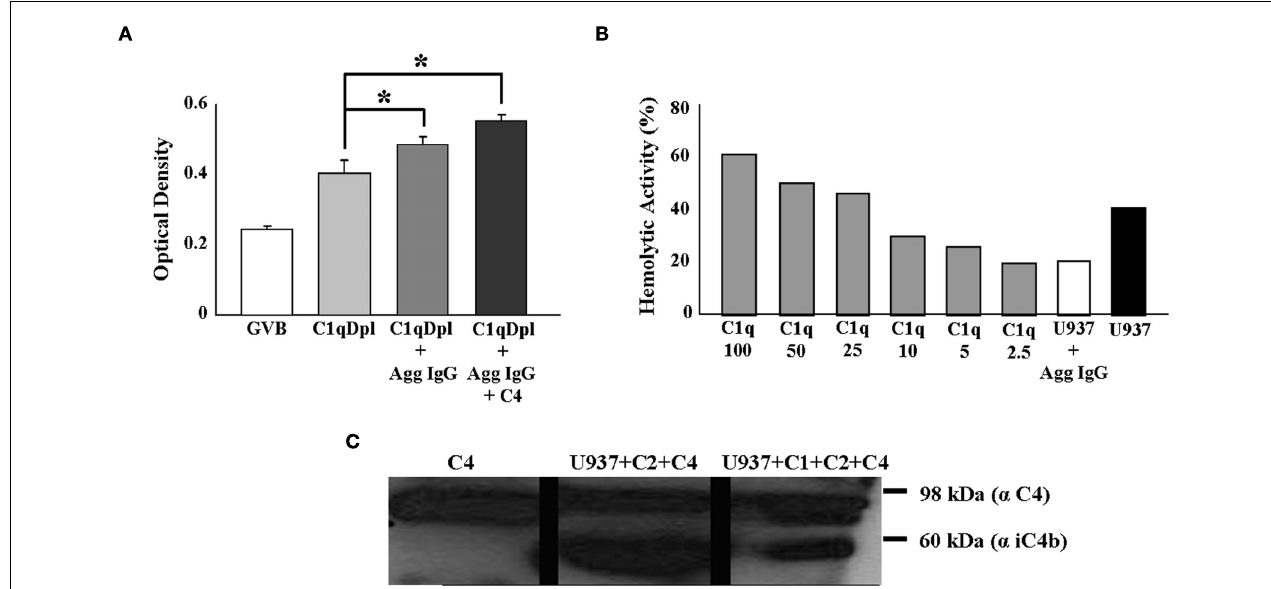
FIGURE 4 | Surface-associated C1 complex of U937 cells can initiate complement activation. (A) C1q on the surface of U937 cells triggers the complement cascade of the classical pathway. U937 cells were attached to a microtiter plate and incubated with a 1:10 dilution of Clq depleted serum (C1qDpl) ± aggregated IgG (Agg IgG) ± C4. Activation of complement was detected by sequential addition and incubation of biotinylated anti-C4d Ab, alkaline phophatase conjugated neutrAvidin, followed by pNPP. C1q-depleted serum was used as a negative control ( n = 3) * p < 0.05. (B) Surface C1q on U937 cells activates complement in a hemolytic assay. 2 × 10 6 U937 cells were incubated with